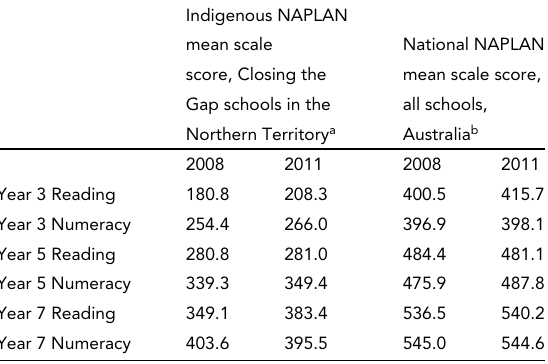
TABLE 1 Comparison of Outcomes for Closing the Gap National Partnership Schools in the Northern Territory with NAPLAN Mean Scores for All Schools in Australia Indigenous